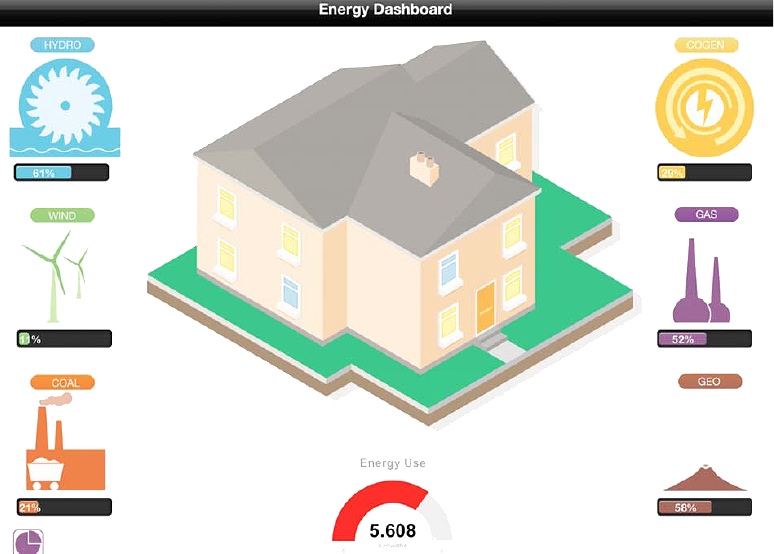
Figure 3. An example of the use of gauges in an energy visualization dashboard for showing both the current power consummation level (at the bottom center), as well as the current power generation levels (on either sides). Image from Reference